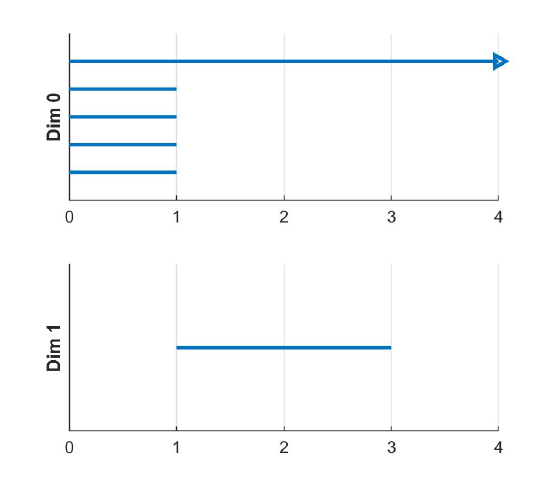
Figure 4. 0-dimensional and 1-dimensional persistent barcodes of the filtration in Figure